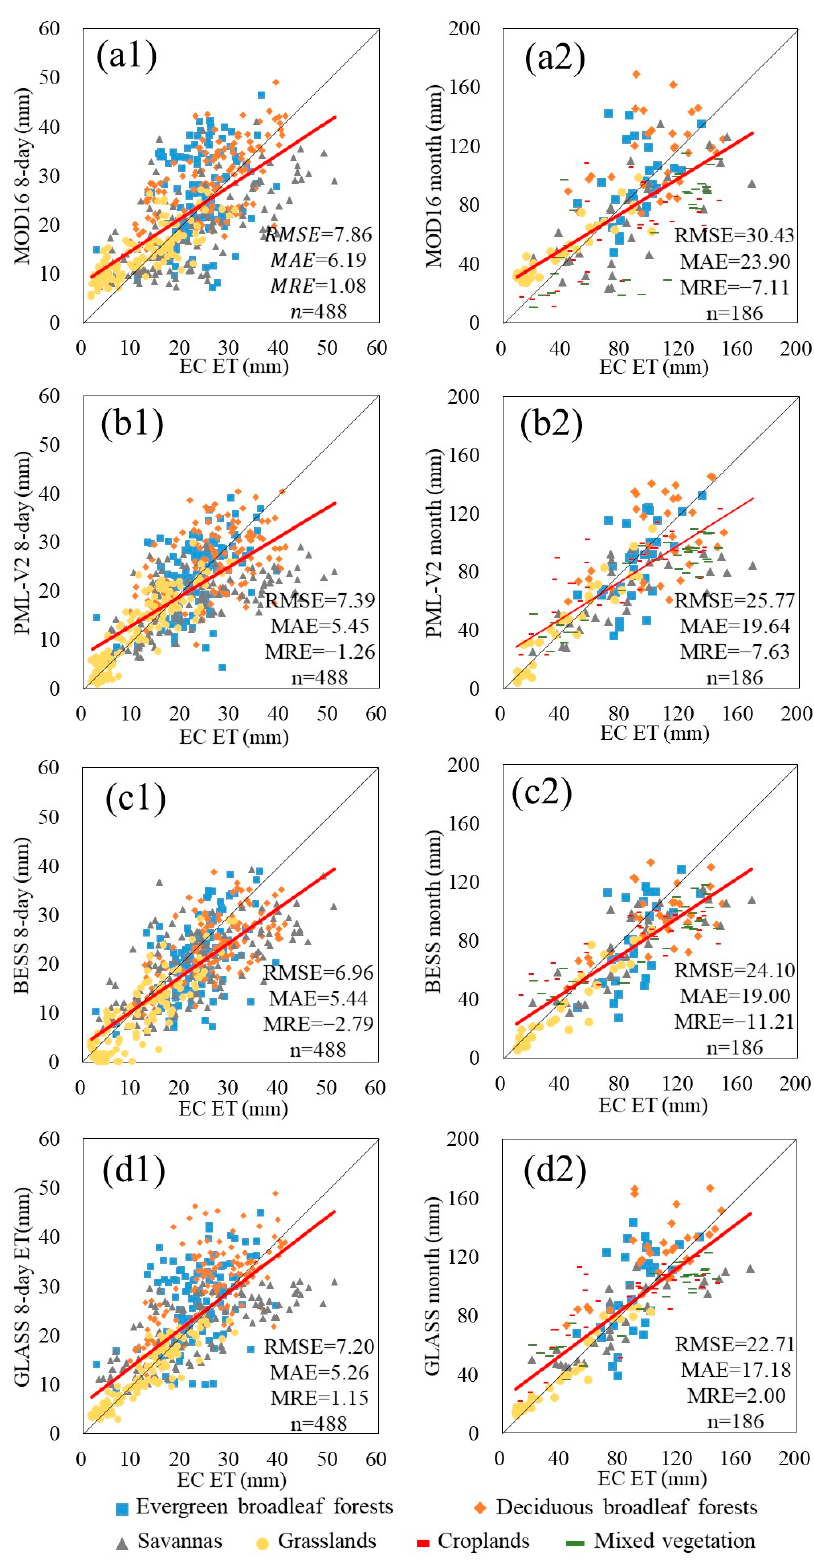
Figure 2. Scatterplots of 8-day ( a1 , b1 , c1 and d1 for MOD16, PML-V2, BESS and GLASS, respectively) and monthly ( a2 , b2 , c2 and d2 for MOD16, PML-V2, BESS and GLASS, respectively) ET products against EC ET for all the assessing sites.